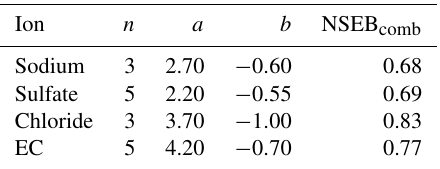
Table 4. Summary of values a , b , and n used to obtain the optimal NSEB comb